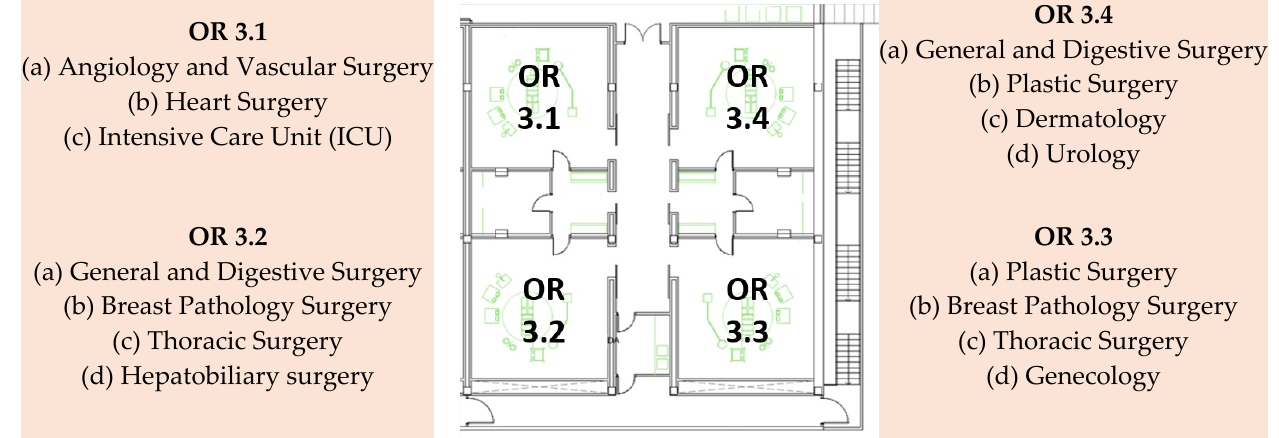
Figure 1. Surgical Block No. 3, with Four OR Types of TAF.